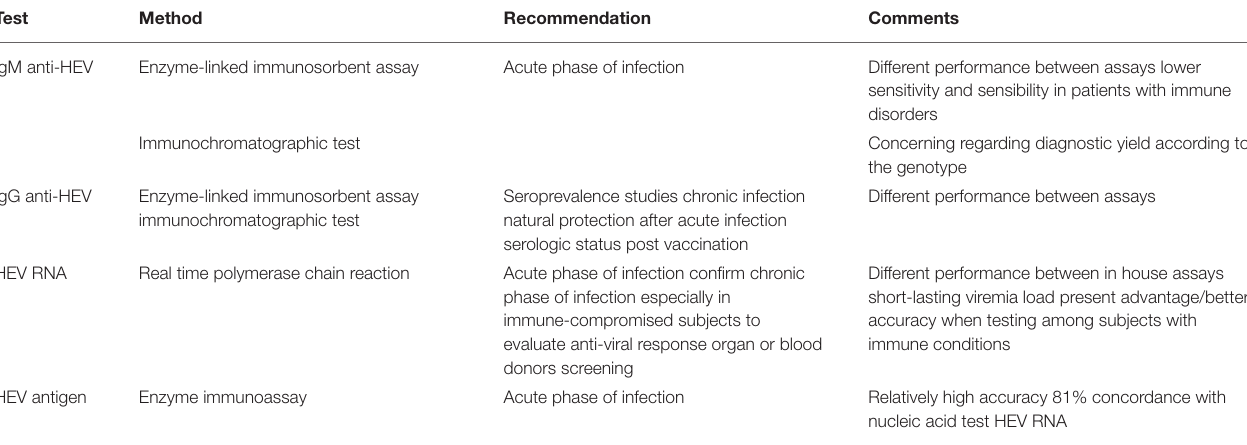
TABLE 5 | The methods used for HEV